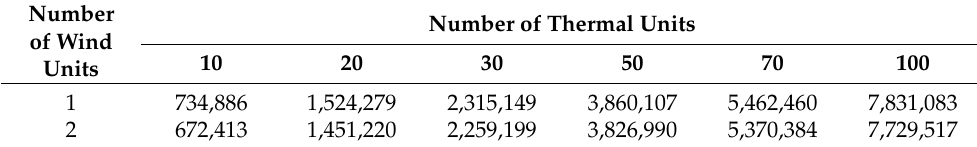
Table 6. Comparison of the total system costs of a system with one vs. two wind units